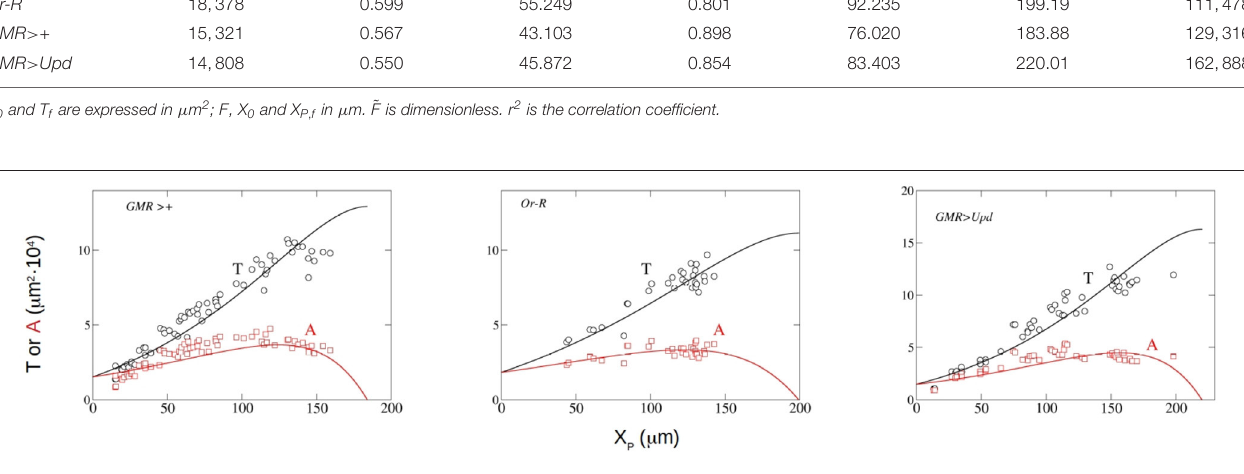
FIGURE 2 | Experimental measurement of P (black circles) and A (red squares) along with least-square fitting results to Equations (15) (black line) and (14) red line for the Drosophila strains GMR > + , Or-R and GMR > Upd . In the three panels, the x-axis represents X P in µ m and the y-axis depicts A and P in 10 − 4 · µ m 2